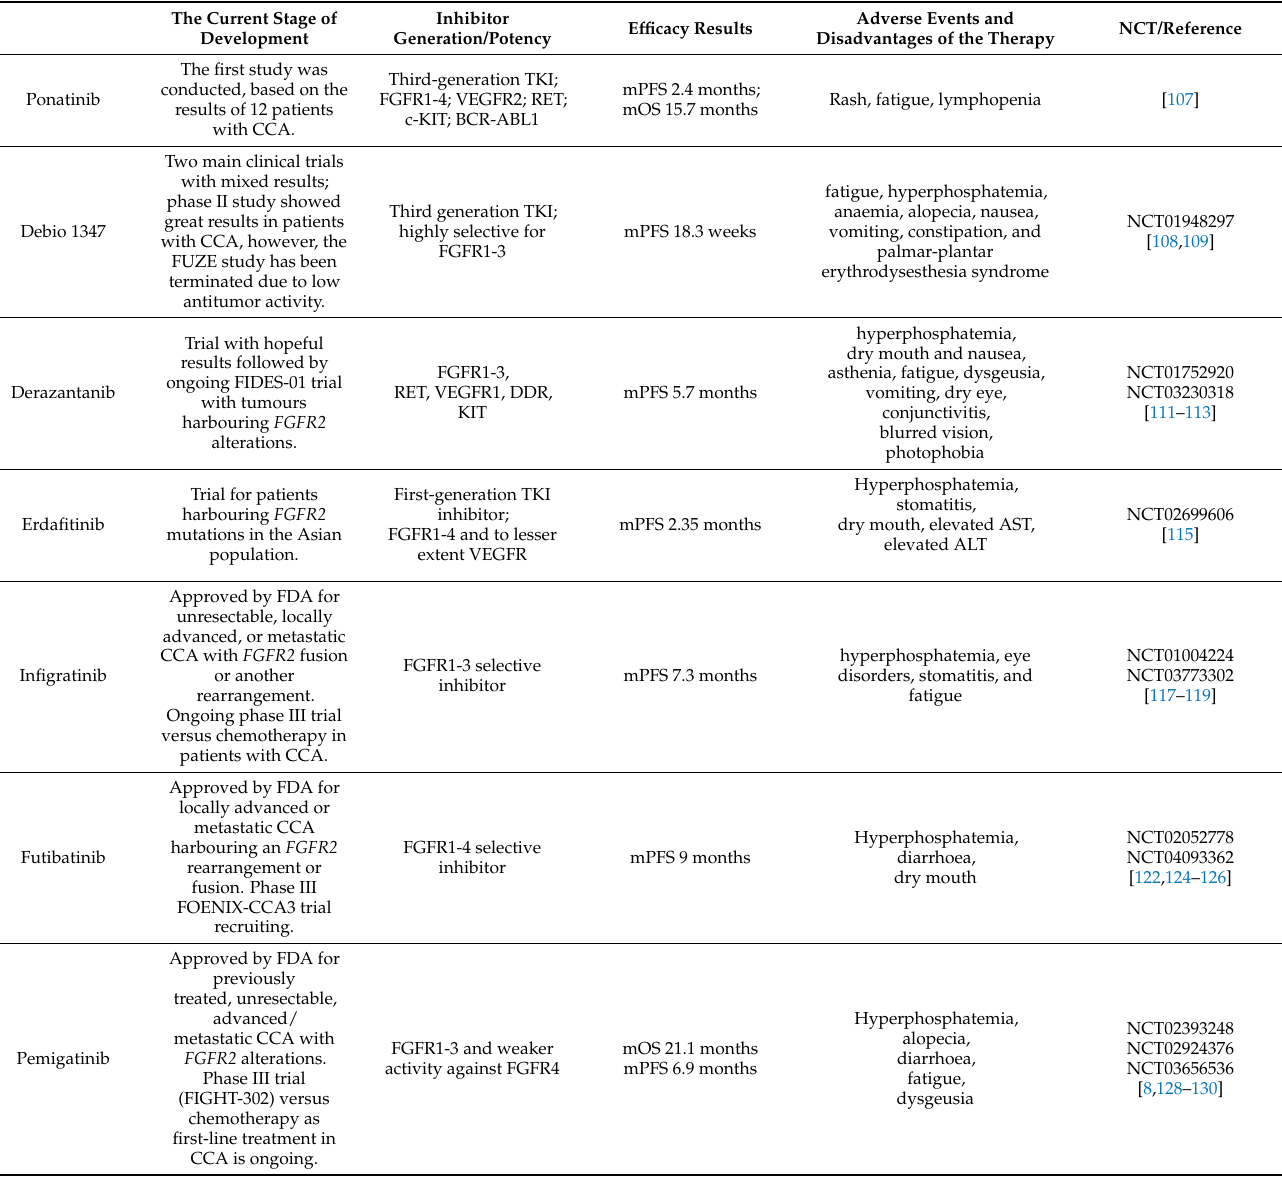
Table 1. Current status of FGFRi in clinical development for